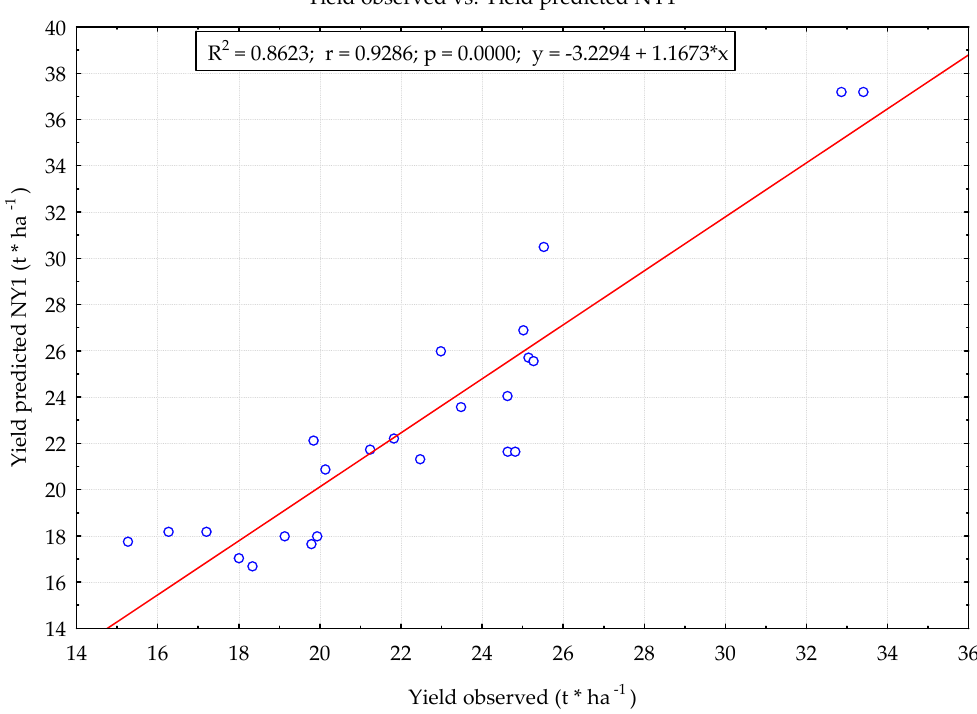
Figure 5. The scatter plot between observed and predicted values according to the NY1 model using Bp subset data.